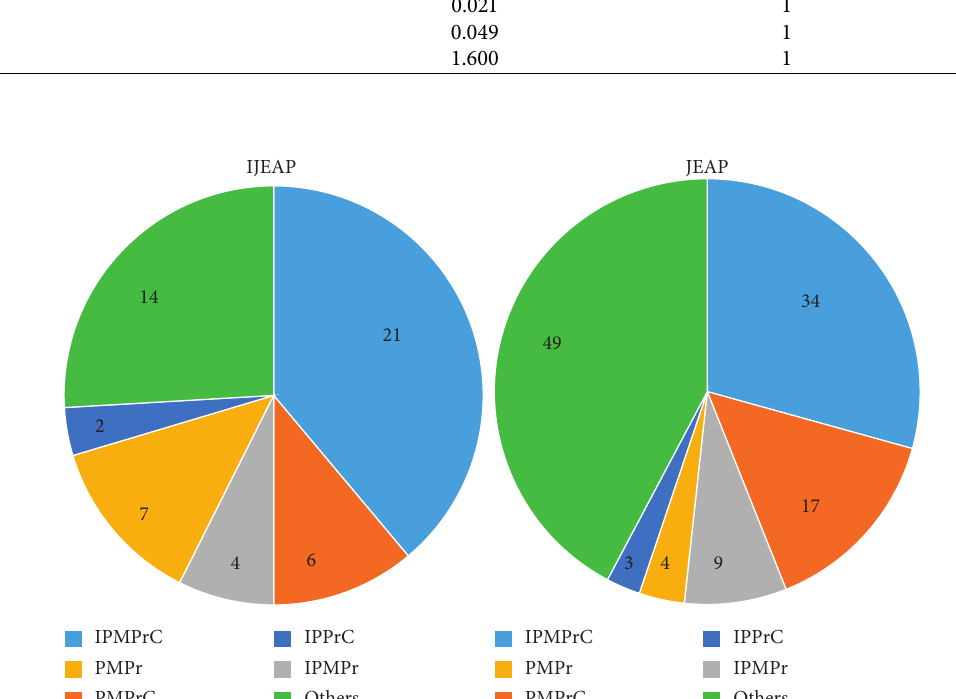
Figure 1: Percentage of the most frequent move patterns in IJEAP and